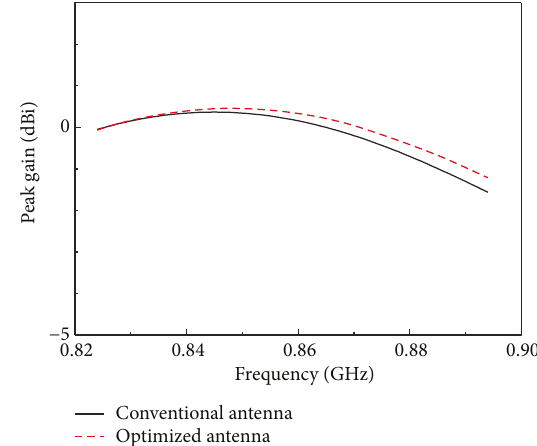
Figure 6: Simulated peak gains of the conventional and optimized antennas.